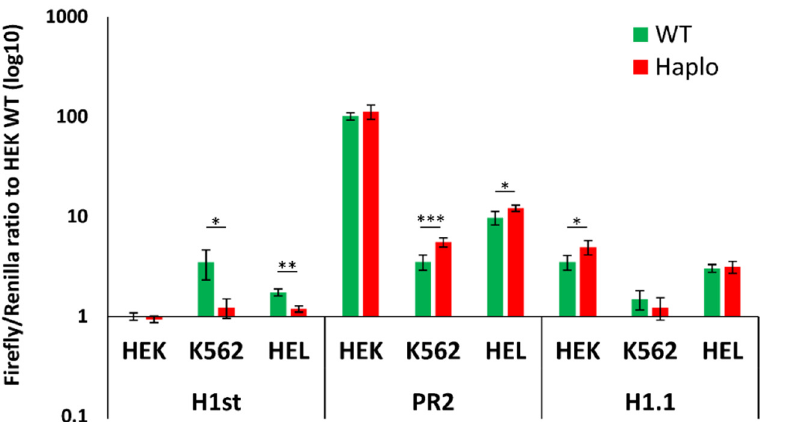
Figure 2. Evaluation of the dual-luciferase assay results by comparing the wild-type (WT) and the minor haplotype region (Haplo)-driven luciferase expression. The Firefly/Renilla luciferase activity ratio was normalized to the activity obtained in HEK cells with the WT constructs. Replicates: n = 5 in case of HEK and K562, n = 4 in case of HEL cells (significance by t -test: * p < 0.05, ** p < 0.01, *** p < 0.001).